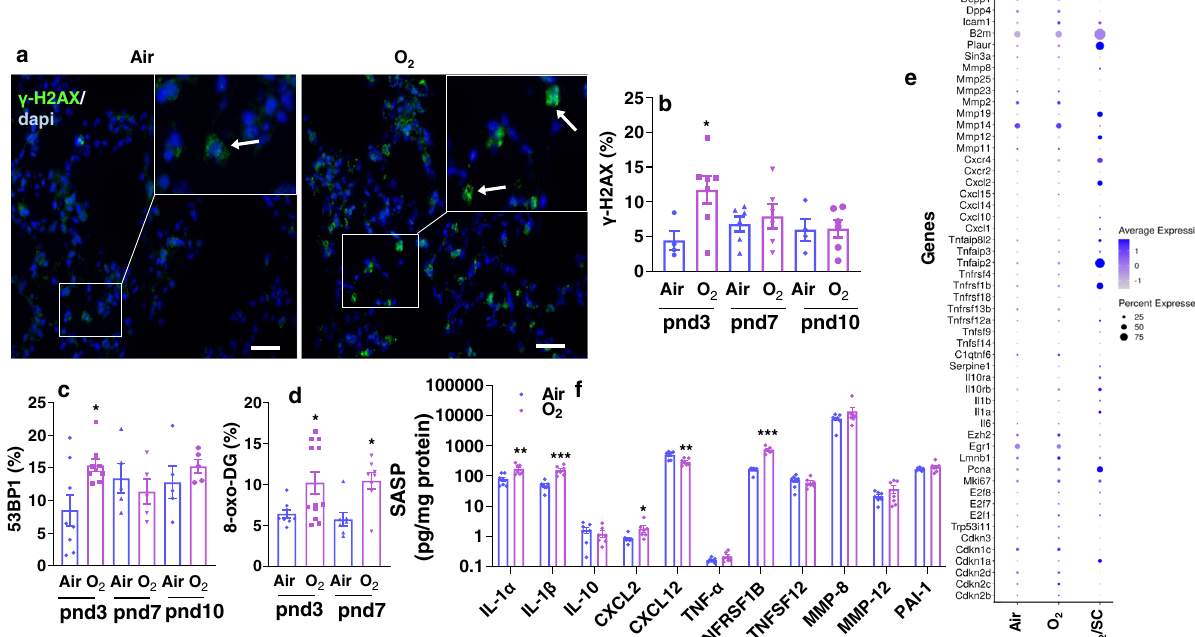
Fig. 3 | Neonatal hyperoxia increases DNA damage and SASP expression in mouselungs. C57BL/6Jneonatalmice(<12hold)wereexposedtoairorhyperoxia (95% O 2 ) for 3 days. Some mice were then allowed to recover in room air until pnd10. a Immuno fl uorescence was performed to determine expression of γ H2AX. Representativeimagesof γ H2AXstainingasshowningreeninmouselungsatpnd3. Arrowsdenote γ H2AXfoci.Barsize:25 µ m. b Cellspositivefor γ H2AXwerecounted and normalized into total numbers of nuclei detected by DAPI in mouse lungs at pnd3, pnd7, and pnd10. c Immuno fl uorescence was performed to determine expression of 53BP1. Cells positive for 53BP1 were counted and normalized into total numbers of nuclei detected by DAPI in the lungs. d Immuno fl uorescence was